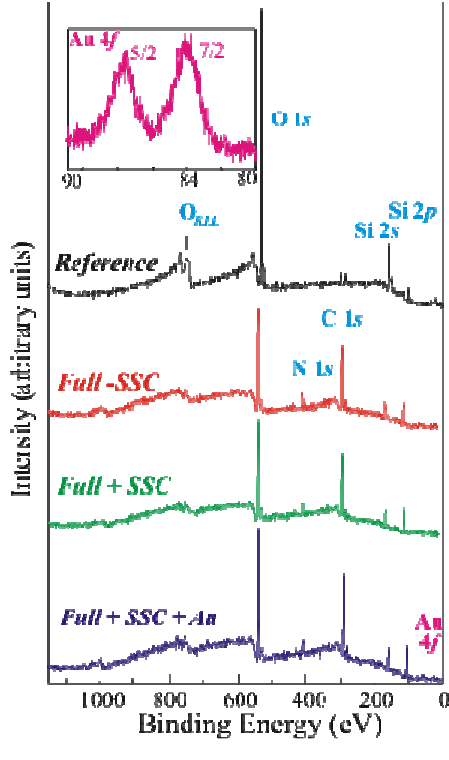
Figure 1. XPS survey spectra of reference (black) and three fully processed samples: processed without SSC (red, Full-SSC), processed with SSC (green, Full+SSC), processed with SSC and GOx labelled with Au nanoparticles (blue, Full+SSC+Au). In the inset, a zoom between 80eV and 93eV showing the Au 4 f shell signal of the last mentioned sample. No signal was observed in the other